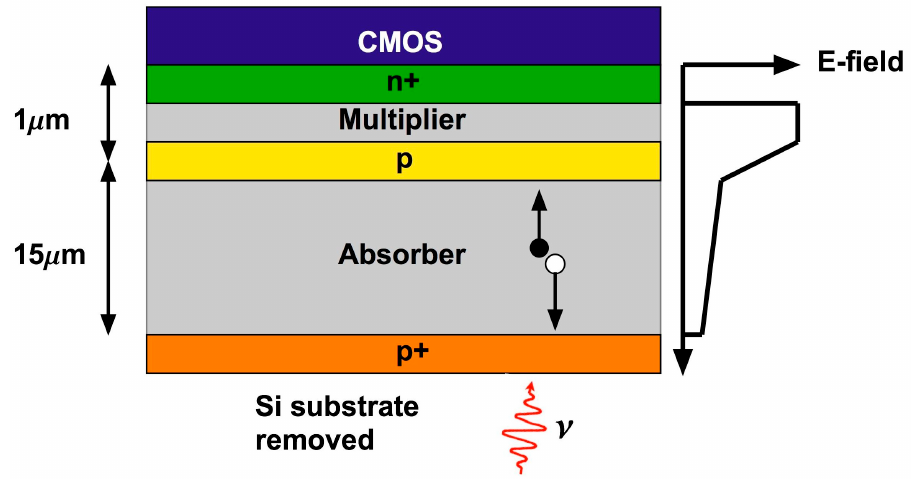
Figure 2. Simplified cross section showing pixel structure, field profile, and operation.